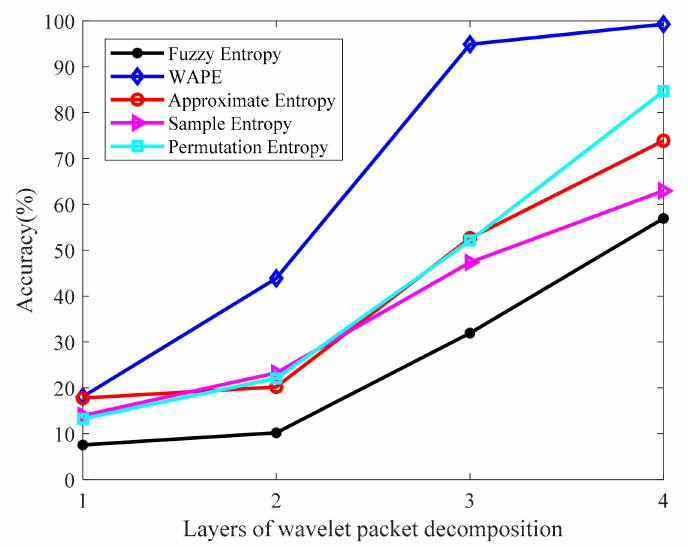
Figure 9. Comparison of different forms of permutation entropy under wavelet packet decomposition with different